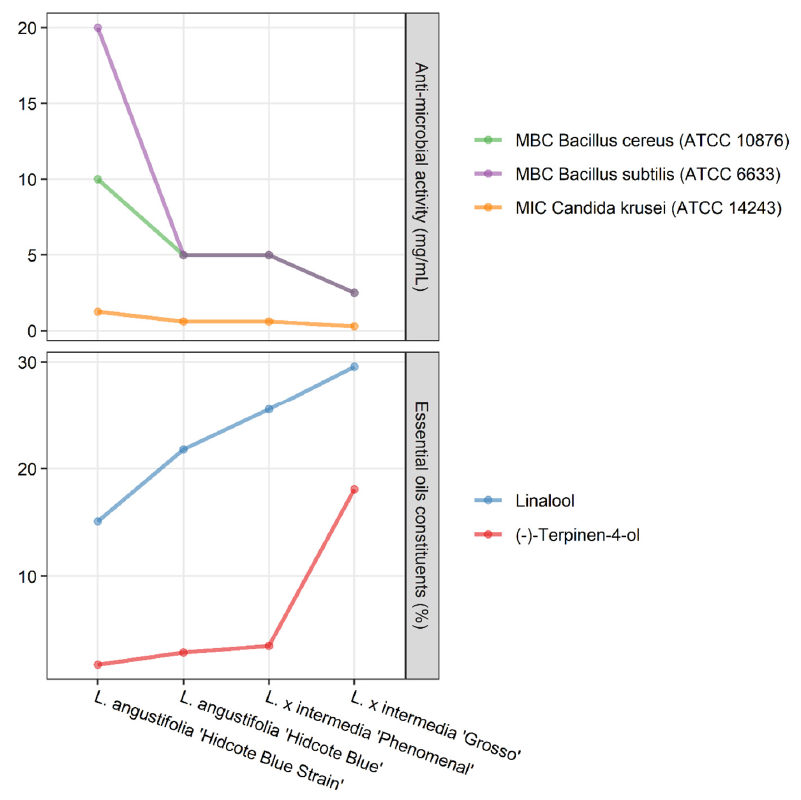
Figure 4. The most probable relationships between the percentage content of essential oil constituents and the biological activity of studied essential oils. The higher content of linalool and terpinen-4-ol is potentially related to lower doses of MBC for B. cereus (ATCC 10876), MBC for B. subtilis (ATCC 6633), and MIC for C. krusei (ATCC